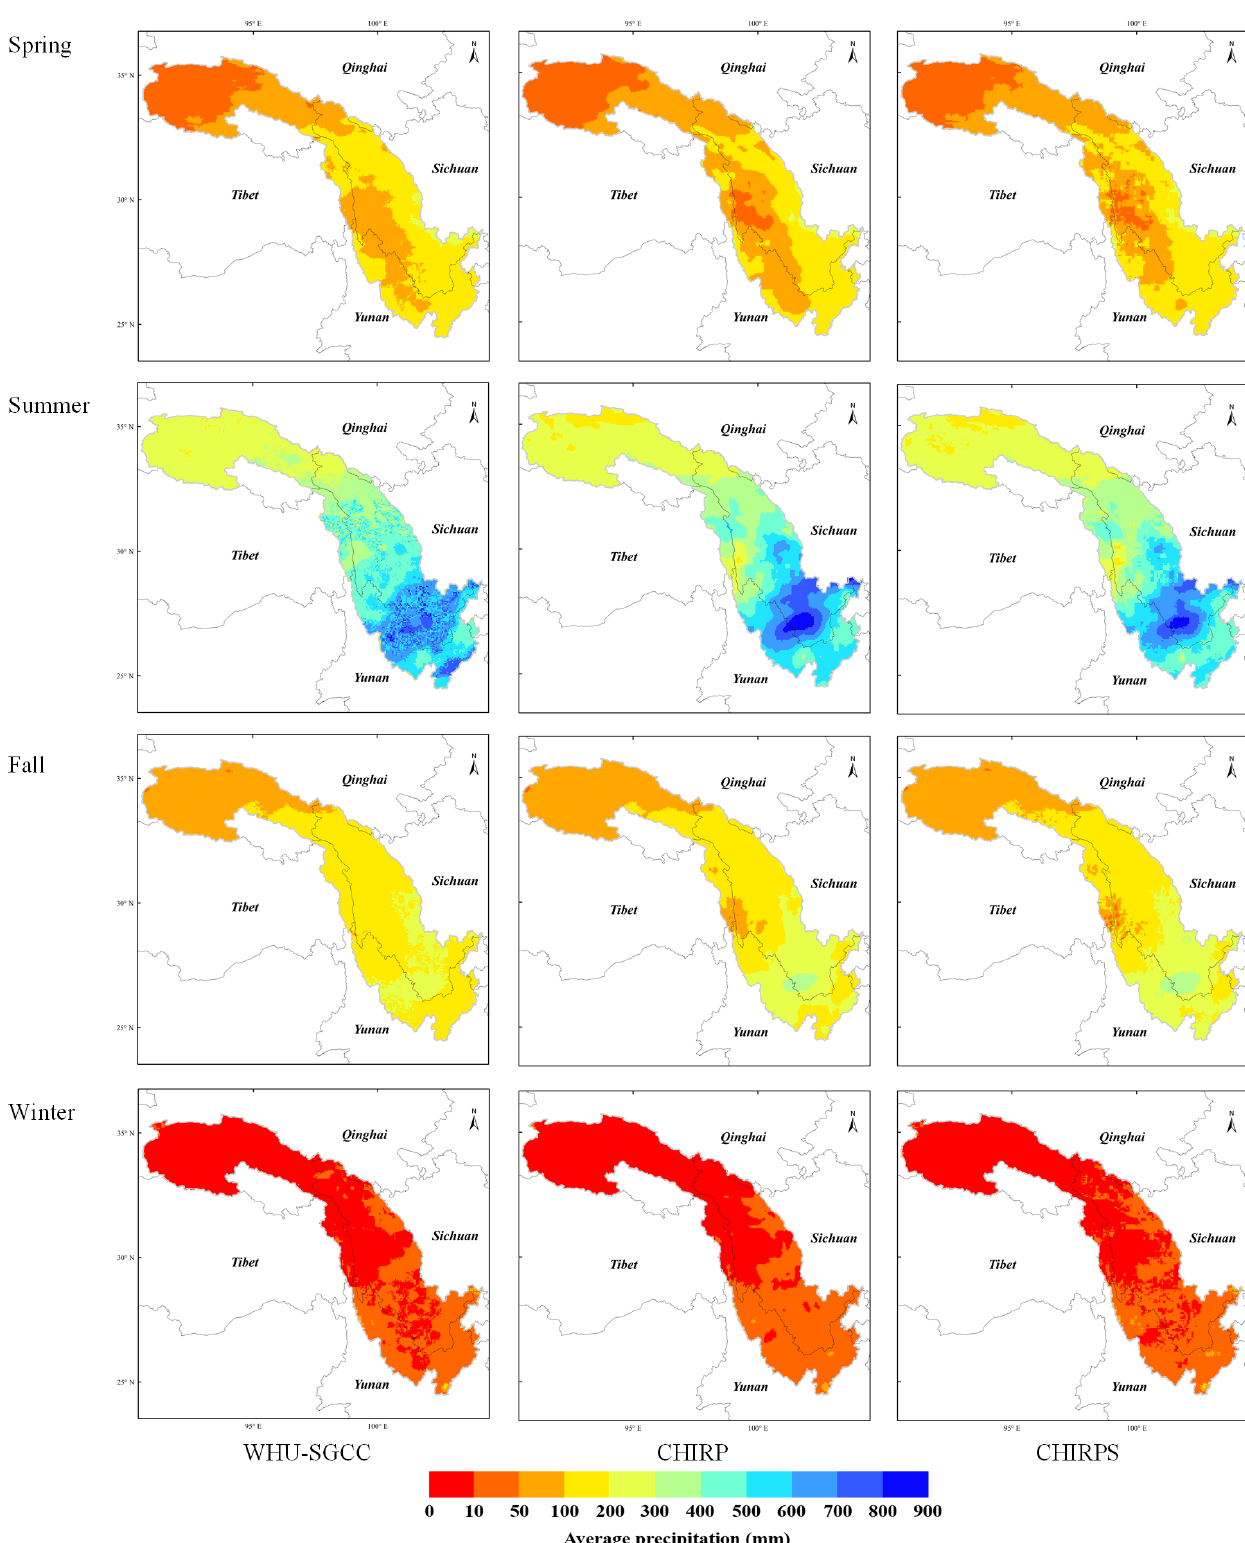
Figure 4. The multi-annual (1990–2014) average seasonal precipitation over the Jinsha River basin interpolated from WHU-SGCC, CHIRP, and